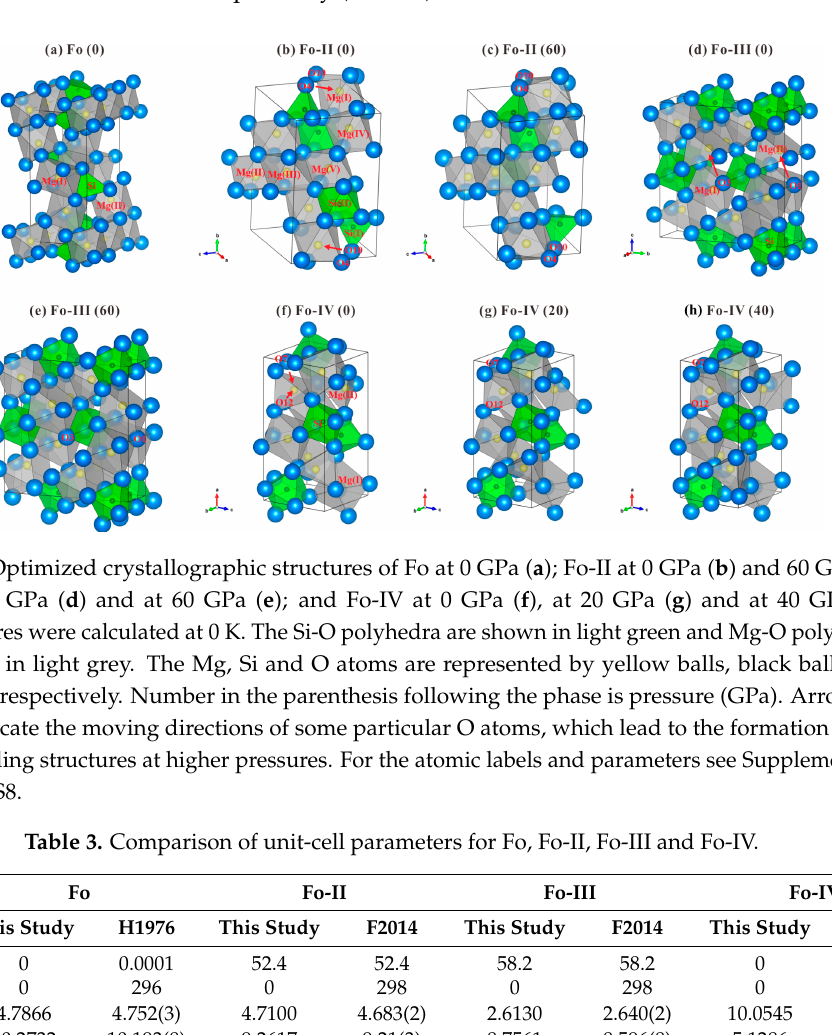
Table 3. Comparison of unit-cell parameters for Fo, Fo-II, Fo-III and Fo-IV.